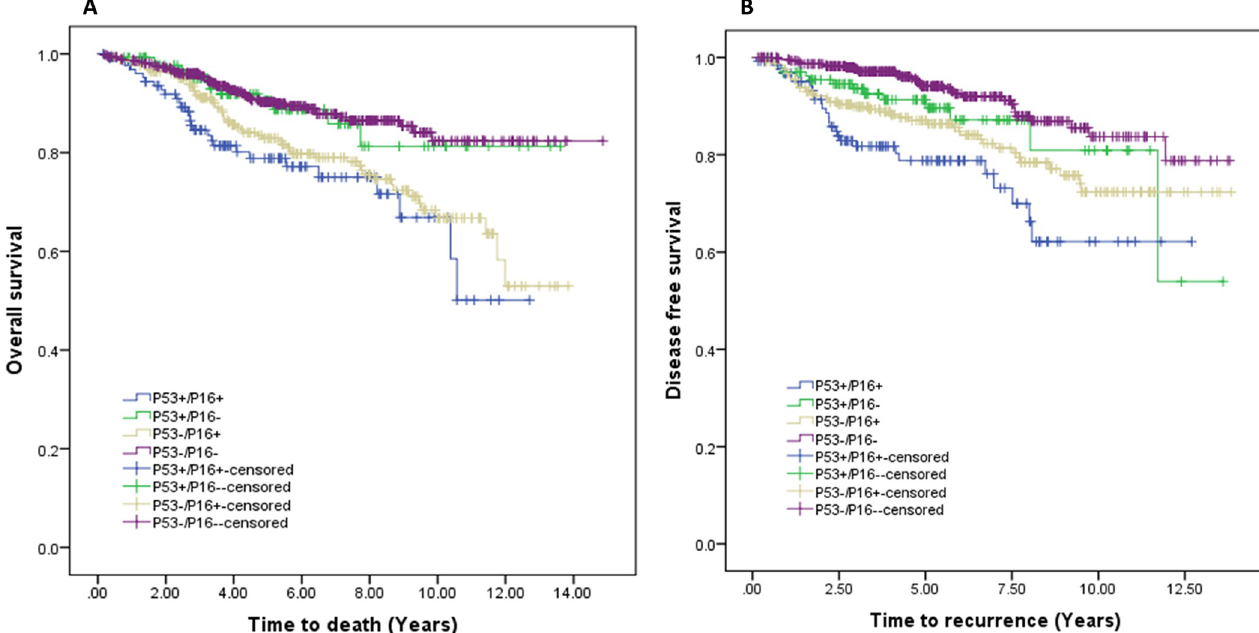
Fig 4. Survival probability based on joint effect of P53 and p16 expression. A: Overall survival probability, P53+/P16+ VS. P53-/P16- (p = 0.000), P53+/P16 + vs. P53+/P16- (p = 0.008), P53+/P16- VS. P53-/P16+ (p = 0.049) and P53-/P16+ vs. P53-/P16- (p = 0.000) showed significant differences on overall survival. The worst outcome was seen in patients P53+/P16+ tumours. B : Disease free survival, P53+/P16+ VS. P53-/P16- (p = 0.000), P53+/P16+ vs. P53+/P16- (p = 0.017) and P53-/P16+ vs. P53-/P16- (p = 0.000) showed significant differences in DFS. The worst outcome was seen in patients with P53+/P16+ tumours. https://doi.org/10.1371/journal.pone.0214604.g004 (Fig 4). The worst outcome was seen in patients with P53+/P16+ tumours. Relative to patients with P53 and P16 negative cancers, patients with breast cancers displaying strong P53 and P16 expressions had an adjusted 4-fold increased risk of having disease recurrence (HR = 3.748, 95% CI: 2.251–6.239) and 3-fold increased risk of all-cause related death (HR = 2.632, 95% CI: 1.656–4.183) (Table 5).